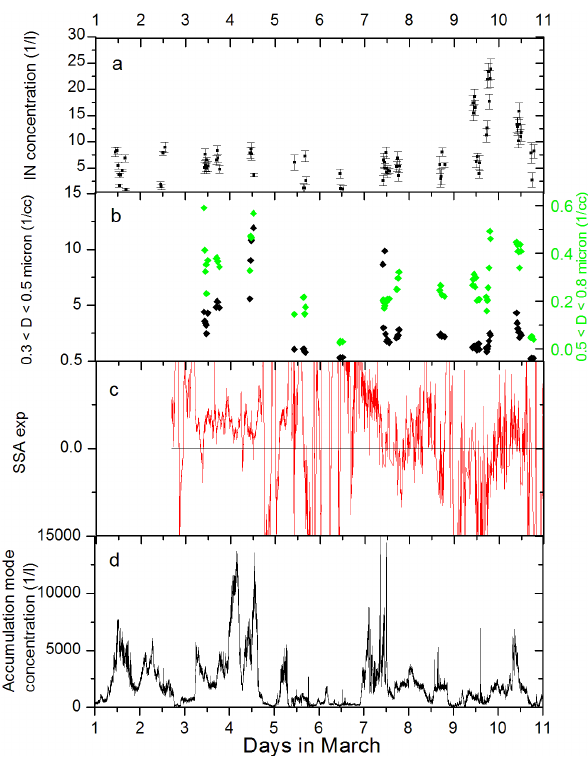
Fig. 4. Panel (a) : Time series of the 15 minutes IN average num- ber concentration (particles/liter) from 1 to 11 March 2009. Panel (b) : Particles concentration per size class. Panel (c) : Single Scat- tering Albedo (SSA) exponent value. Panel (d) : Particles number concentration in the accumulation